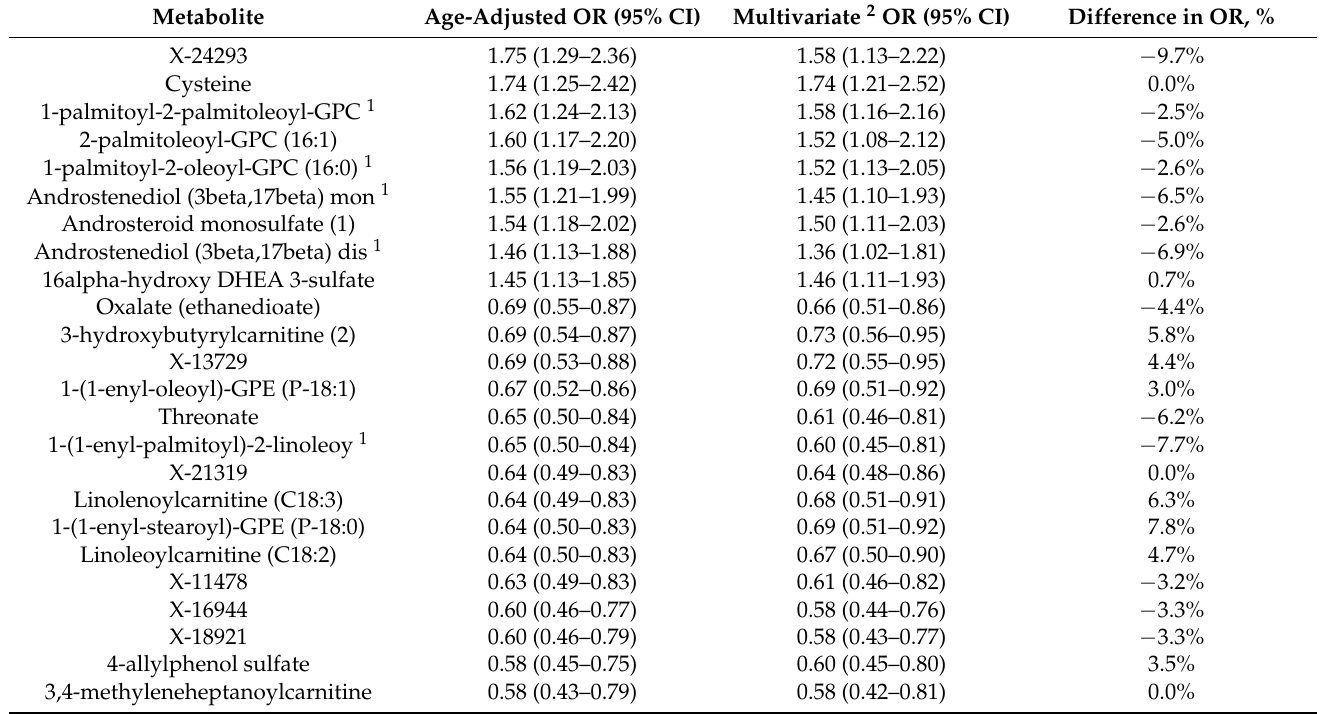
Table 2. Comparison of odds ratios (OR) and 95% confidence intervals (CIs) of breast cancer risk from age-adjusted versus multivariate